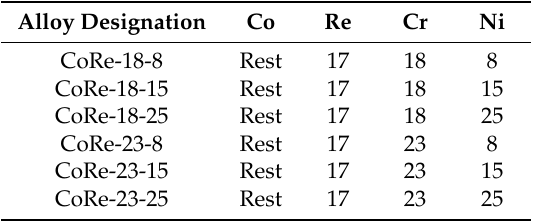
Table 1. Nominal composition of alloys (in atomic